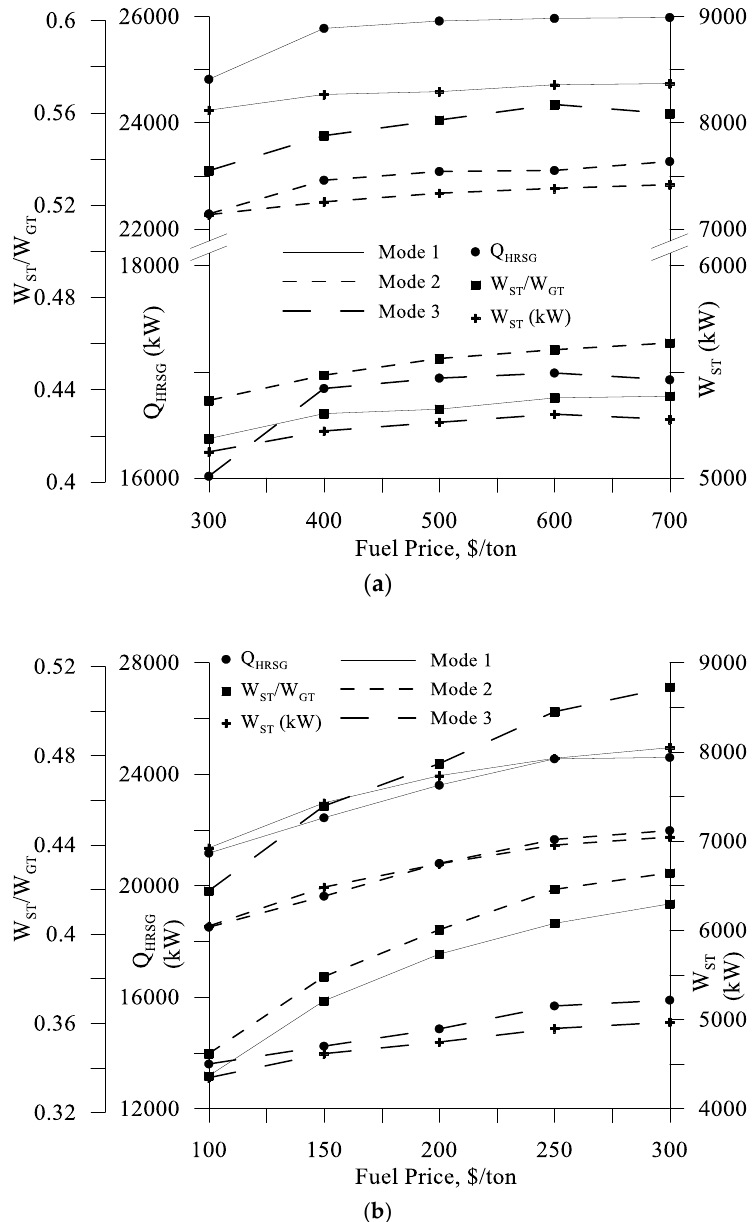
. . Q , ST W and ( b ) the effect of Figure 6. ( a ) Effect of MDO price on the optimal values of Q HRSG , W ST and ( b ) the effect of natural HRSG . . . . Q HRSG , W ST , and W ST / W GT